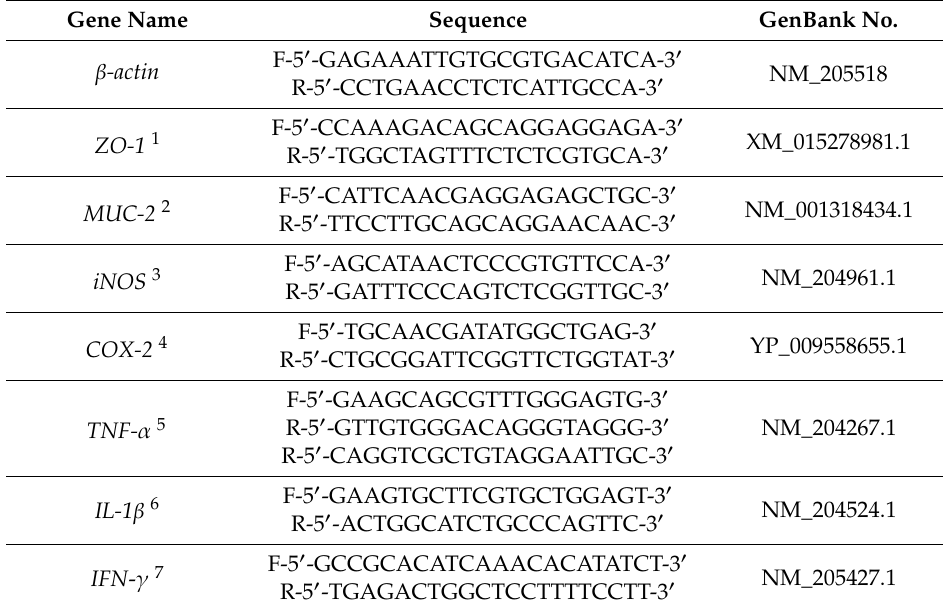
Table 2. Sequences of real-time PCR